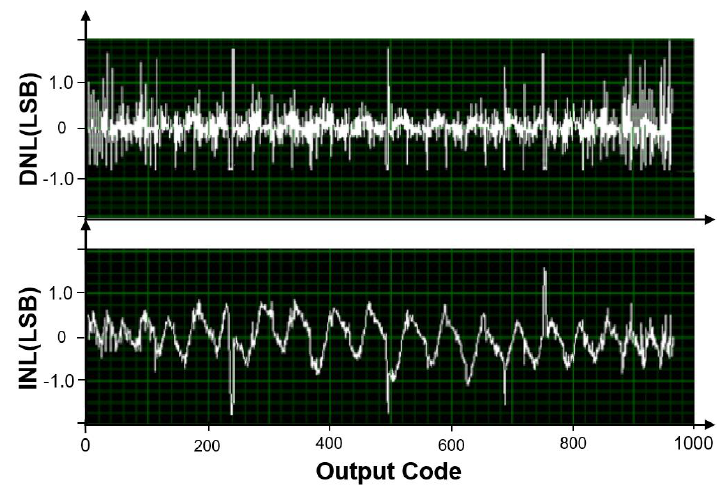
Figure 26. Measured DNL and INL of the proposed PLL-SAR ADC.